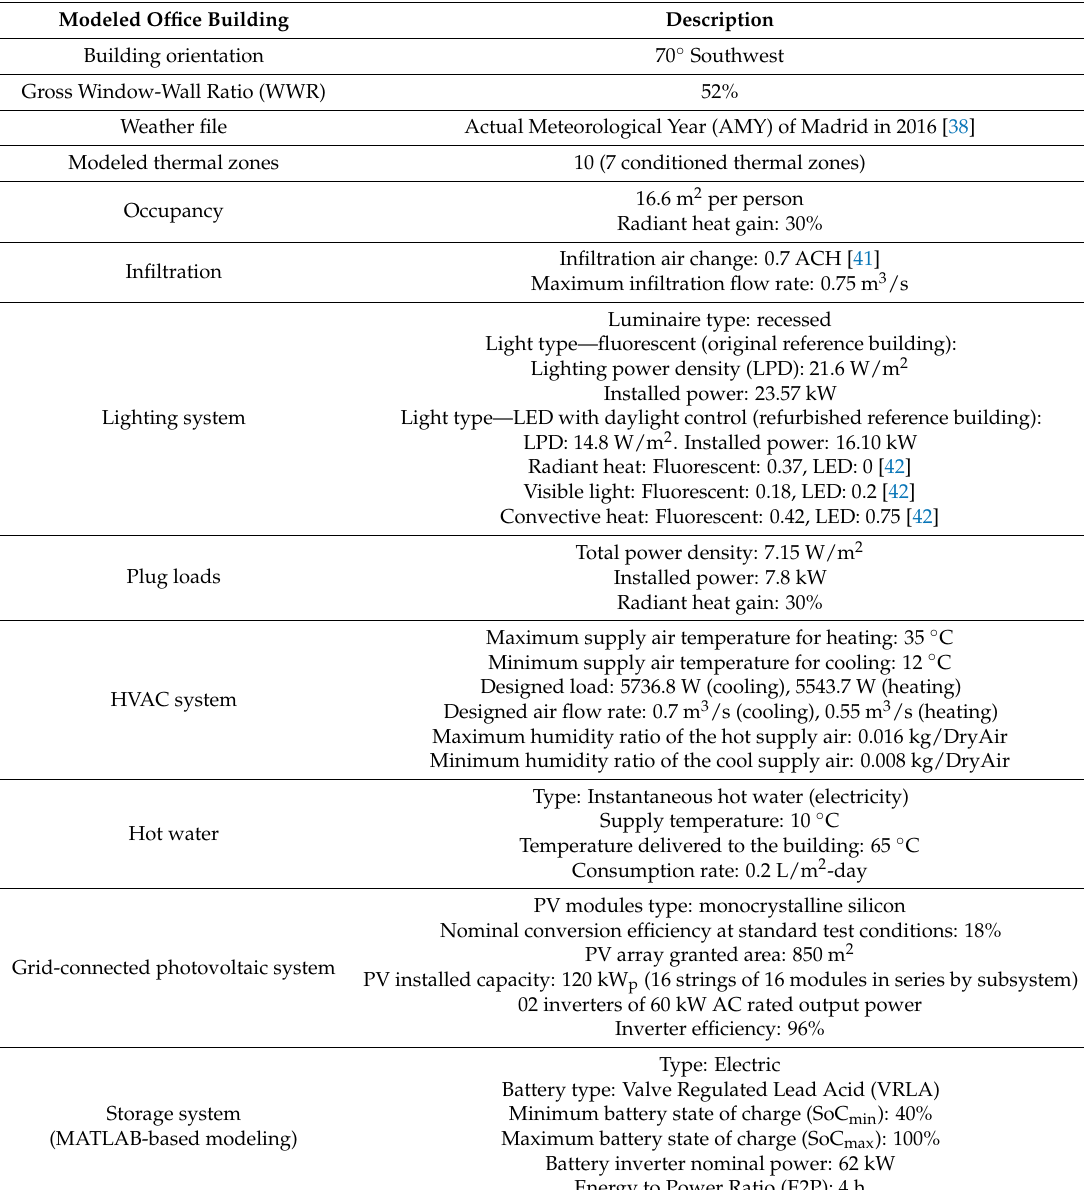
Table 3. Input data for multi-objective simulations performed in the